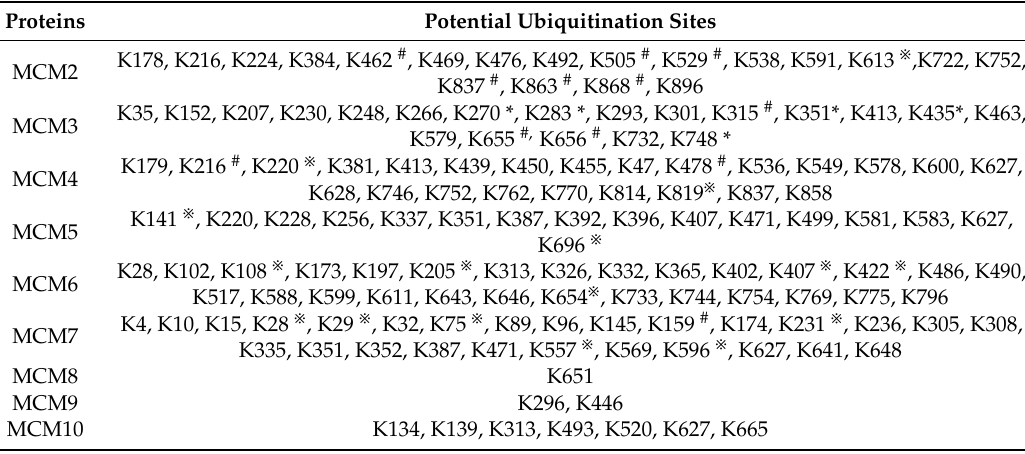
Table 4. MCM ubiquitination in human cancer